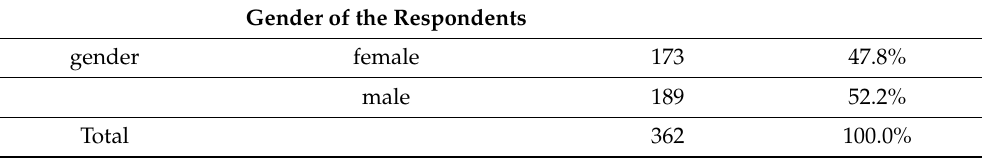
Table 1. Gender of the respondents.